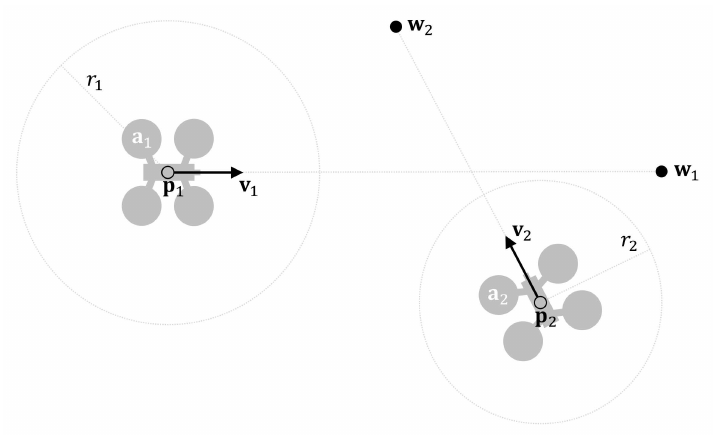
Figure 1. Example of Unmanned Aerial Vehicle (UAV) notation.